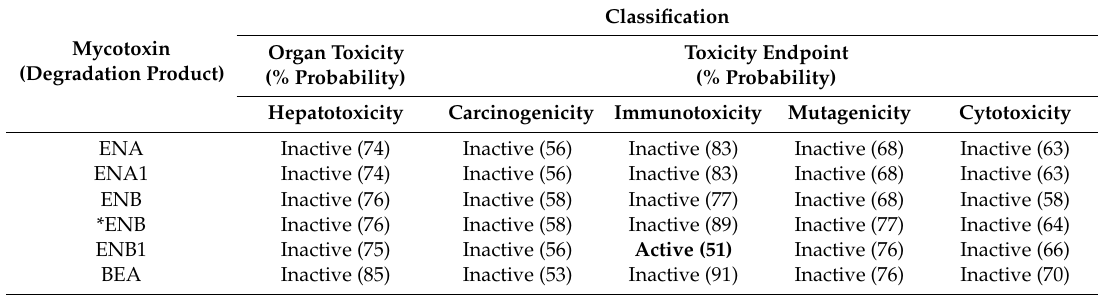
Table 3. Organ toxicity and toxicological endpoint predictions calculated using the ProTox-II web server.